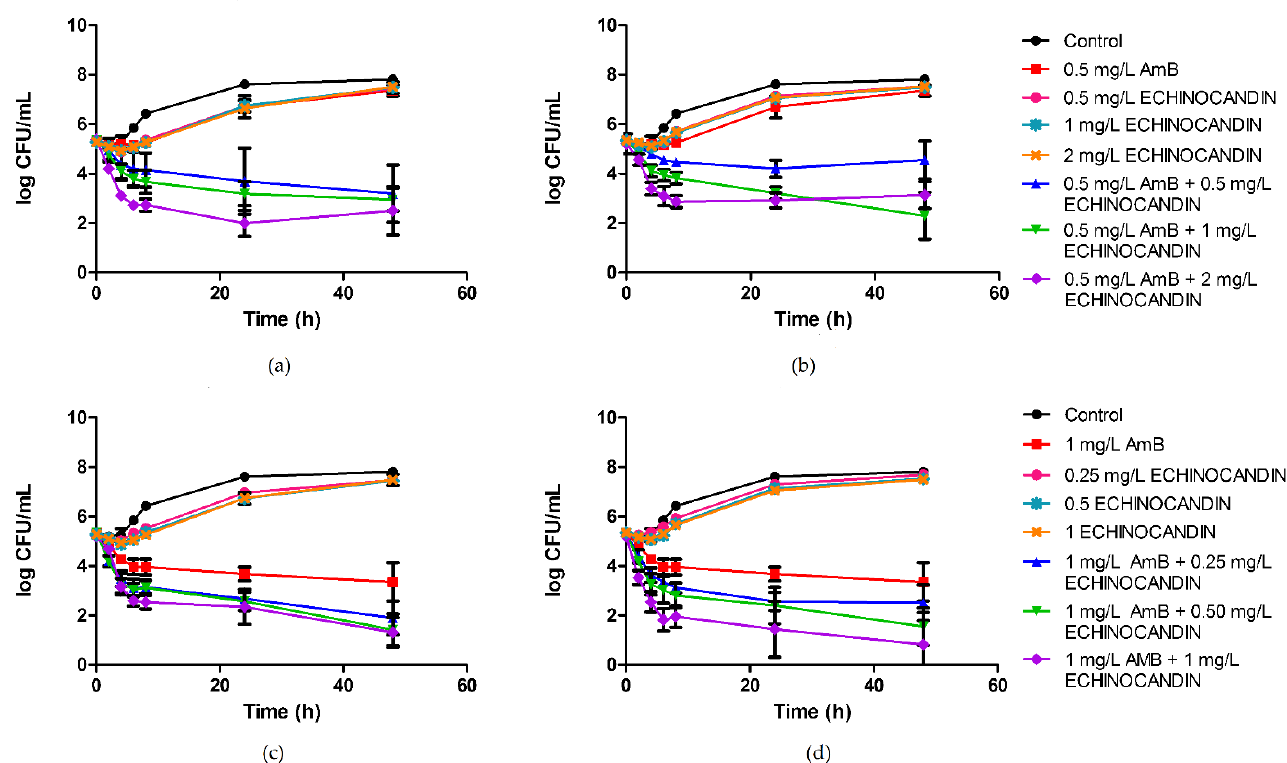
Figure 1. Time–kill curves showing the effects over 48 h of amphotericin B and echinocandins, in monotherapy and in combination, against Candida auris : ( a ) 0.5 mg/L of amphotericin B and anidulafungin; ( b ) 0.5 mg/L of amphotericin B and caspofungin; ( c ) 1 mg/L of amphotericin B and anidulafungin; ( d ) 1 mg/L of amphotericin B and caspofungin. Data are plotted as average data points from the different isolates ± standard error (SE). Antifungal drug concentrations are expressed in mg/L. AmB, amphotericin